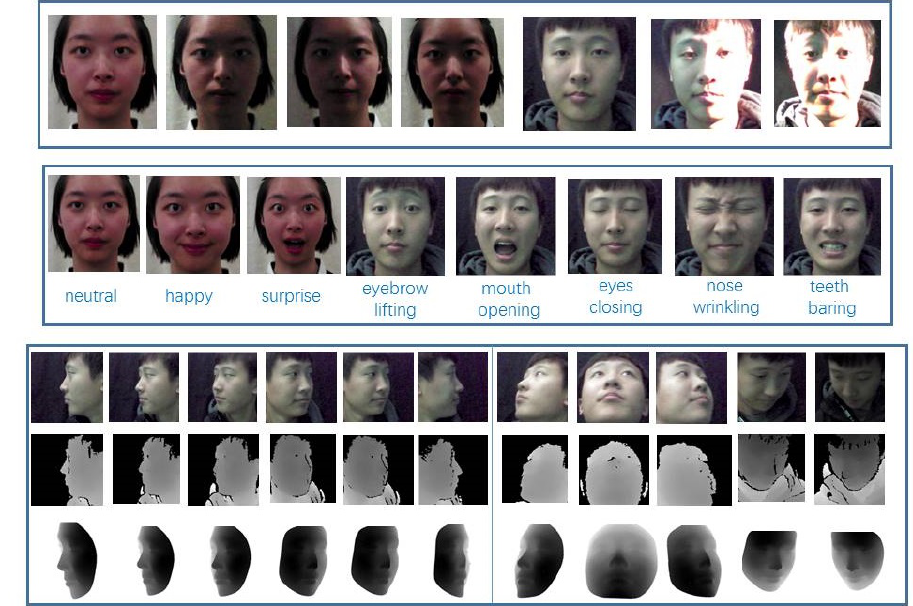
Figure 3. Visual examples in the proposed database. The first line shows the different light conditions where the girl and boy are in version I and II, respectively. The second line shows the different facial expression variations, including 3 expressions of version I and 5 FEs of Version II. The last three lines show the different poses of color, low-quality depth and high-quality depth images, and the first six images belong to P1 while others belong to P2 in each line.